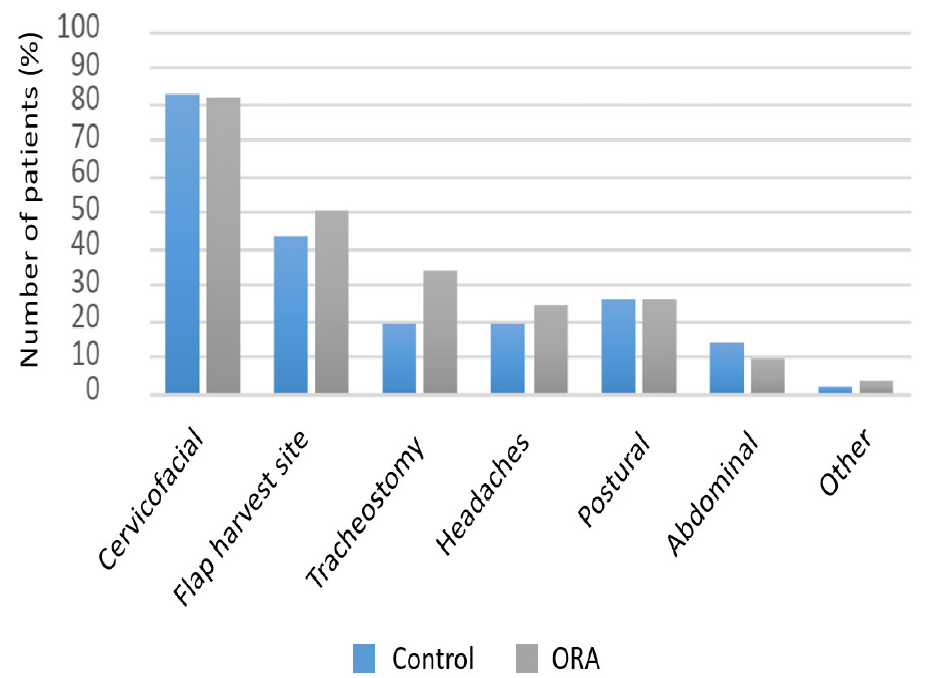
Figure 2. Pain location; ORA: opioid reduced anesthesia.